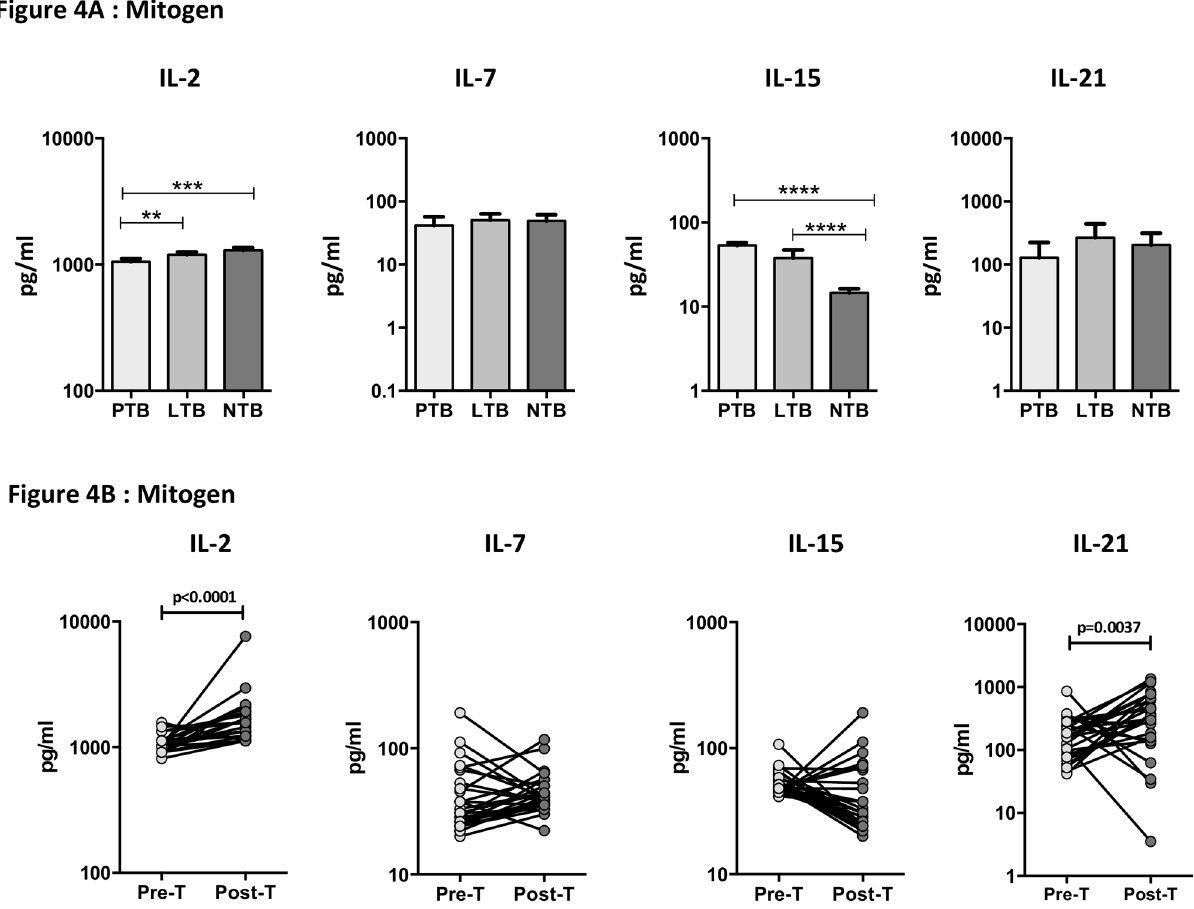
Fig 4. Diminished mitogen stimulated levels of common γ -chain cytokines in PTB individuals and restoration following anti-TB treatment. (A) Mitogen stimulated levels of common γ -chain cytokines IL-2, IL-7, IL-15 and IL-2 were measuredin PTB (n = 30), LTB (n = 30) and NTB (n = 30) individuals. The data are represented as bar graphs showinggeometric means and 95% confidence intervals. P values were calculatedusing the Kruskal-Wallis test with Dunn’spost hoc comparison. (B) Mitogenstimulatedlevels of common γ -chain cytokines IL-2, IL-7, IL-15 and IL-2 were measuredin PTB individuals before (pre-T) and after (post-T) standard anti-TB chemotherapy. The data are representedas line graphswith each line representinga singleindividual.P values were calculatedusing the Wilcoxon signed rank